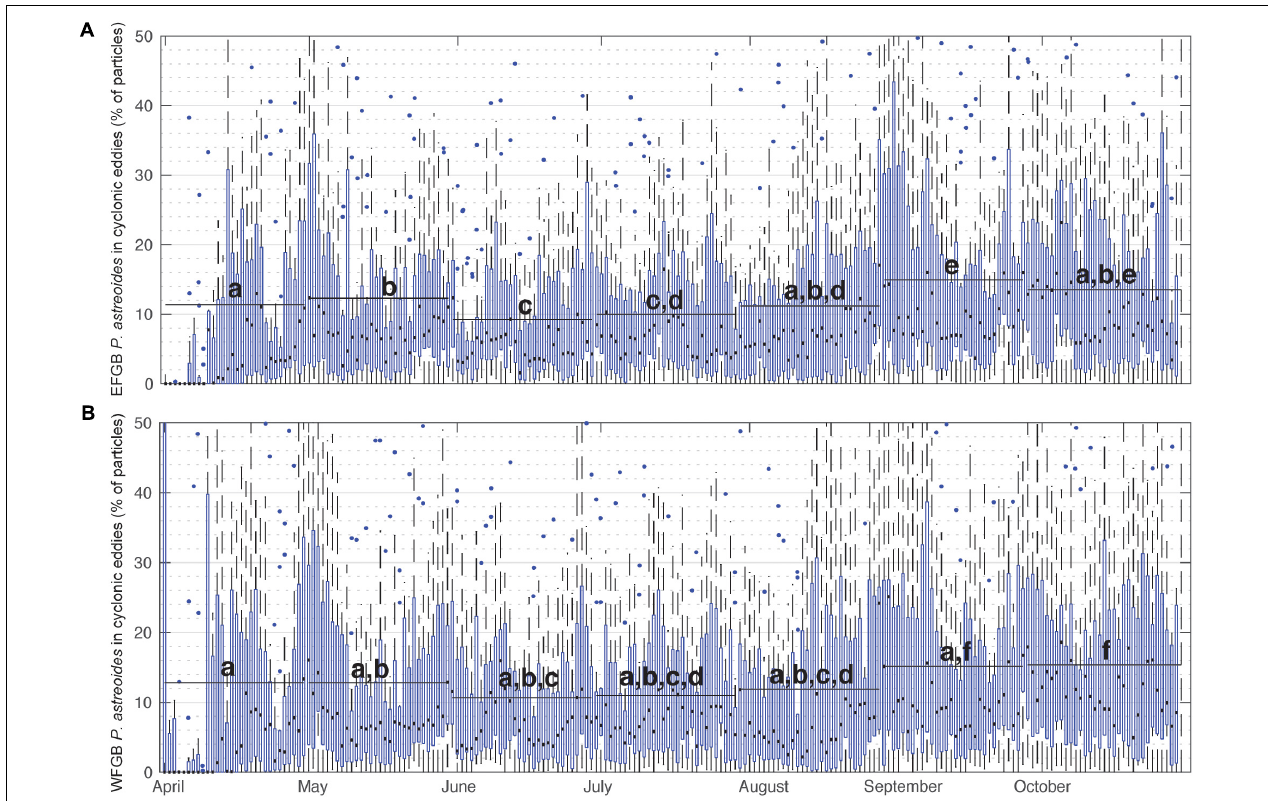
FIGURE 3 | Percentage of P. astreoides virtual larvae entrained in cyclonic eddies over time. Box plots show annual distributions across the 15 years of seasonal planulation (2004–2018) of the percentage of (A) EFGB and (B) WFGB P. astreoides larvae entrained in any GoM cyclonic eddy feature on that day of the year. Boxes are interquartile ranges, black lines are median values, blue circles are outliers, and whiskers represent the first and fourth quartiles. Black bars represent means taken over 30-day windows and letters correspond to significantly different pairwise comparisons (all significant differences p < 0.05, pairwise Wilcoxen tests with Benjamini and Hochberg adjusted p